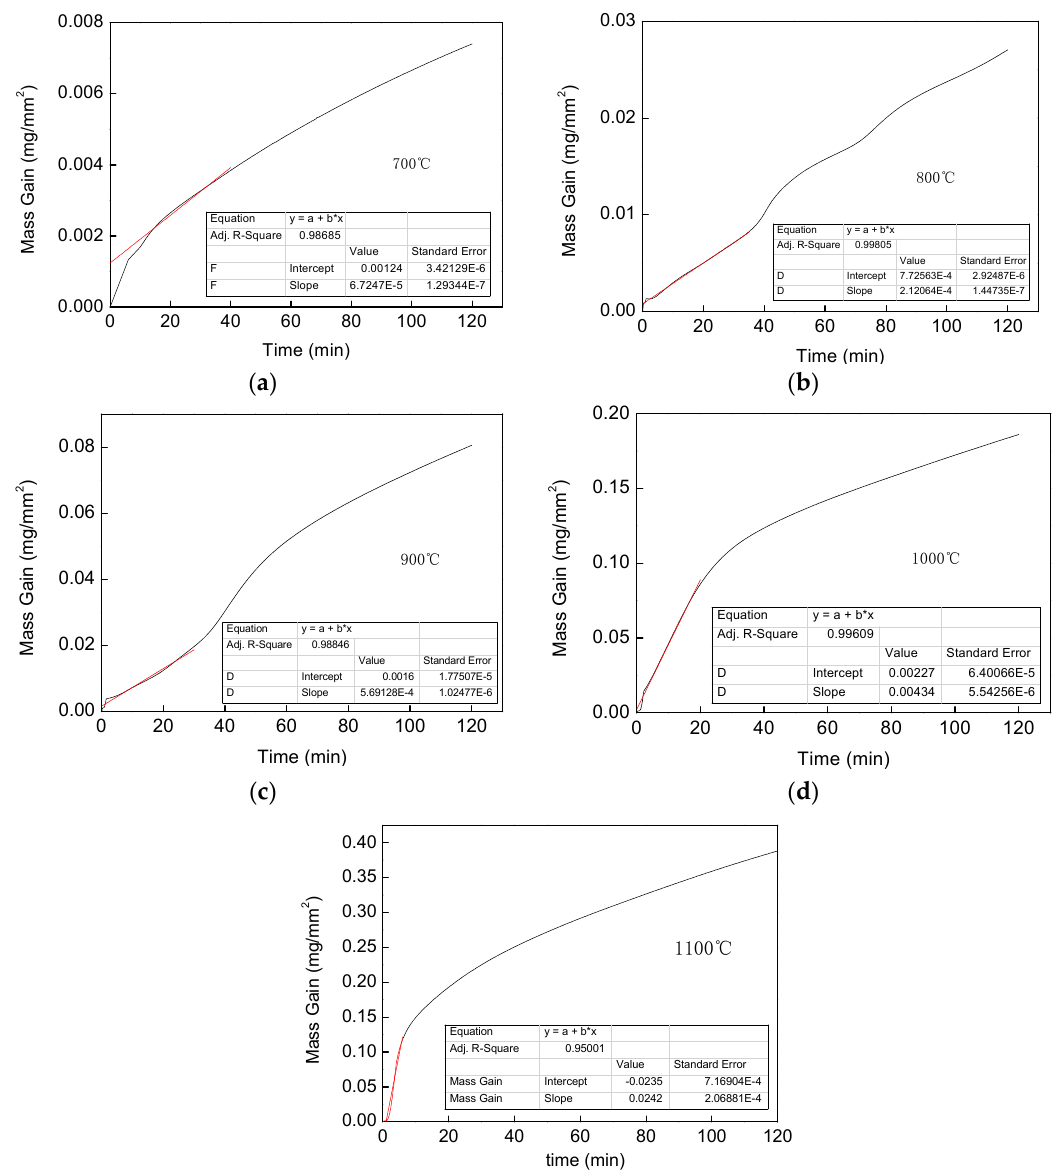
Figure 13. The kinetic plots obtained from the oxidation of steel in a short time. ( a ) 700 °C; ( b ) 800 °C; ( c ) 900 °C; ( d ) 1000 °C; ( e ) 1100 °C.